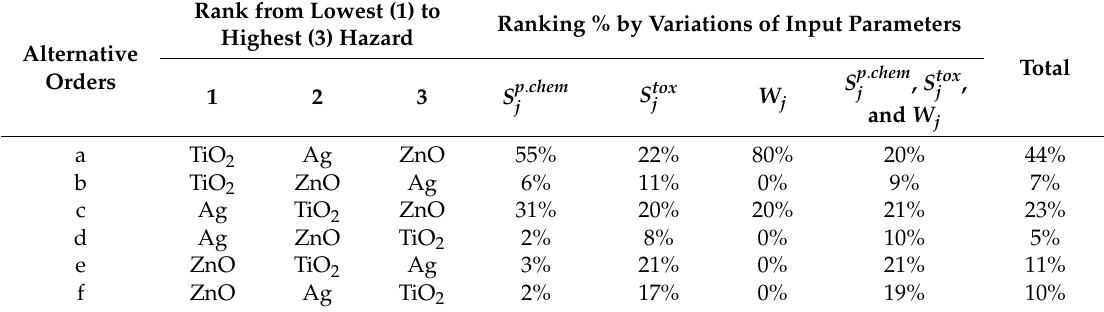
Table 7. Distribution of the hazard ranking order of nanoparticles resulting from Monte